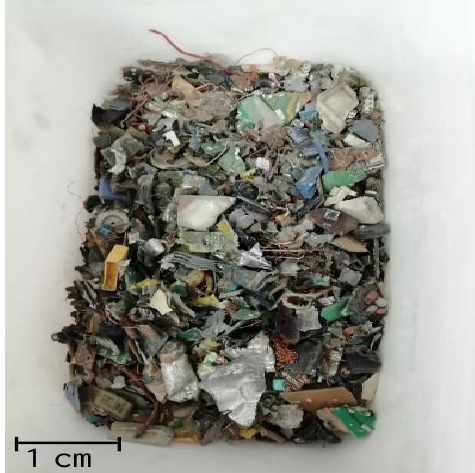
Figure 1. Solid WPCBs starting material.